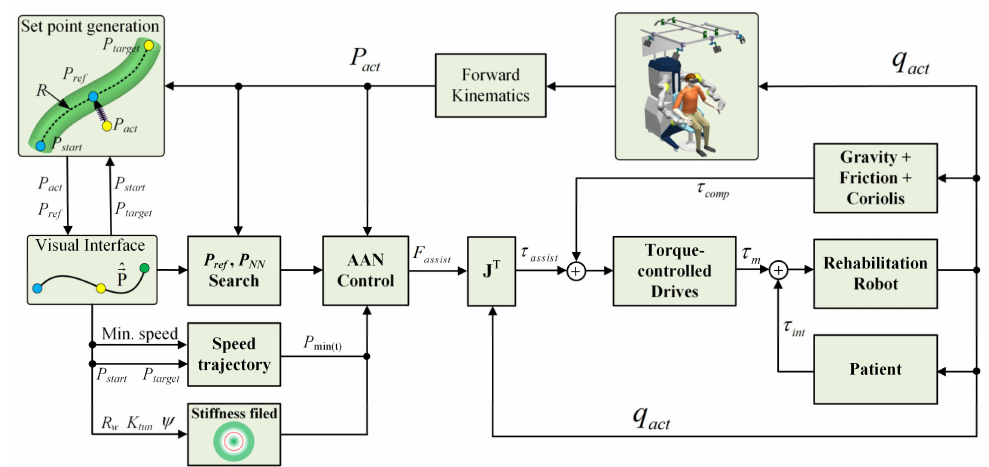
Figure 8. The diagram control scheme of the proposed assist-as-needed controller.